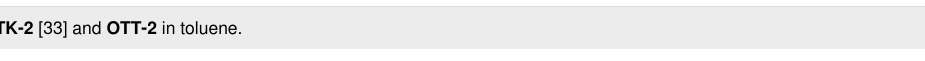
Table 1: Optical data of OTK-2 [33] and OTT-2 in toluene.